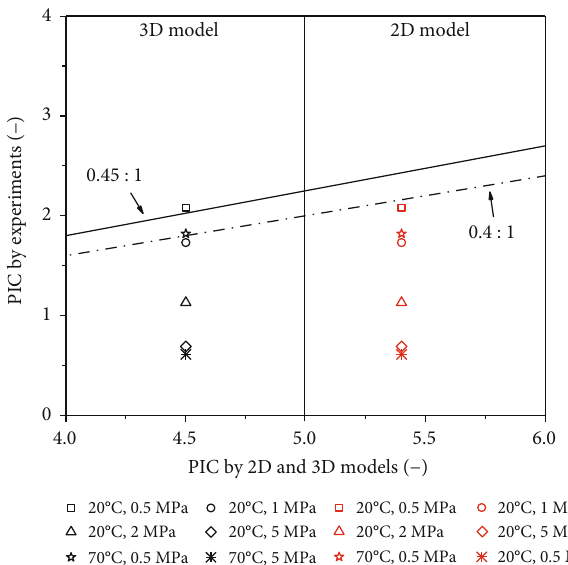
Figure 14: Comparison of PICs predicted by experimental and theoretical models (when the axial strain is